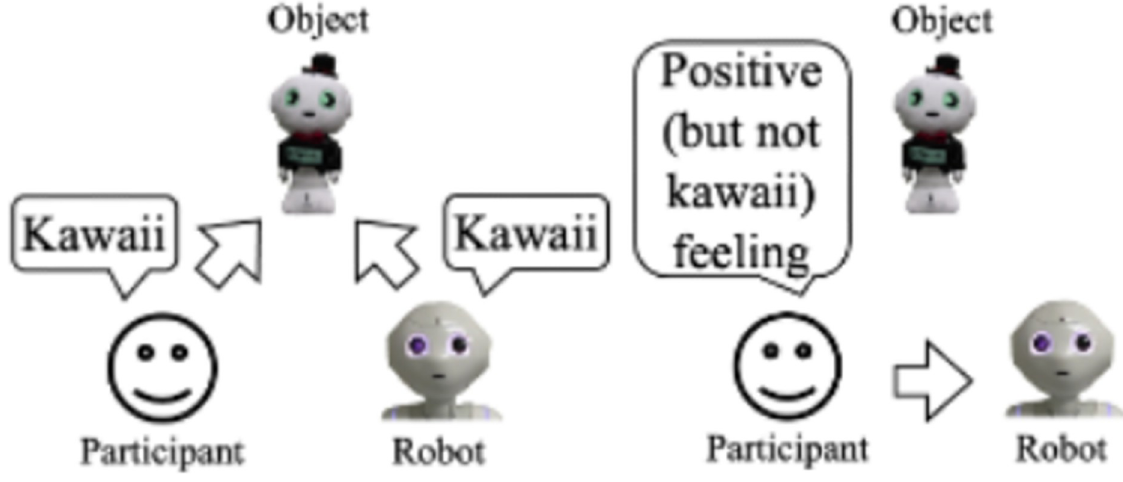
Fig 8. Summary of Experiment I’s